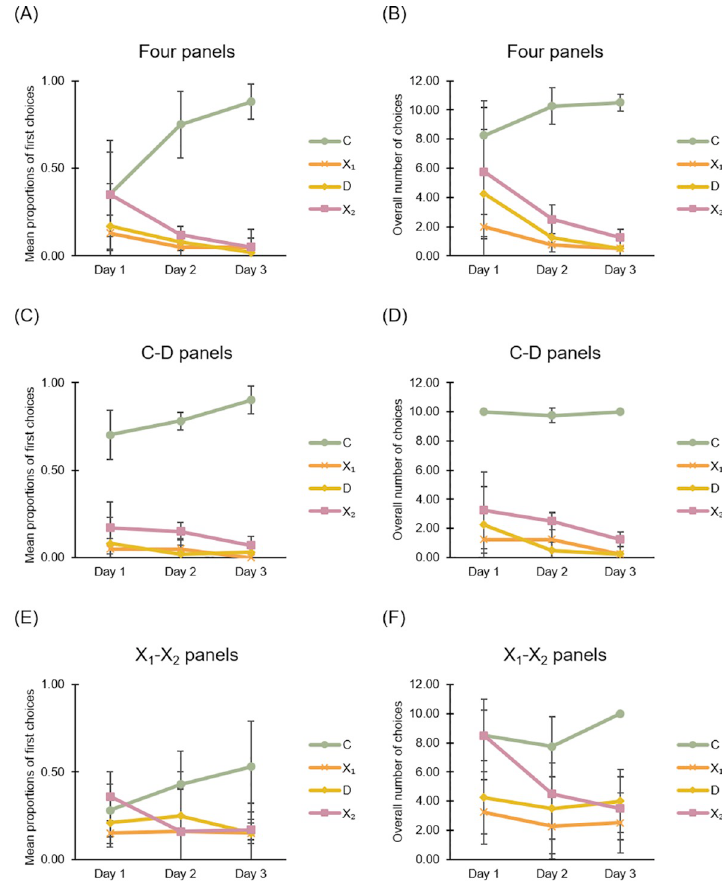
Fig 8. Learning in Experiment 3: Reference memory task in square apparatus with panels. (A) and (B): Graphs show mean (SD) choices at four corridors during the three daily sessions of training (reference memory for rewarded exit) in the square apparatus with four panels at corners, considering in (A) the proportions of first choices and in (B) the overall number of choices. (C) and (D): Graphs show mean (SD) choices during the three daily sessions of training in the square apparatus with two panels at corners C-D, near to the correct corner C, considering in (C) the proportions of first choices and in (D) the overall number of choices. (E) and (F): Graphs show mean (SD) choices during the three daily sessions of training in the square apparatus with two panels at corners X1-X2, far from the correct corner C, considering the proportions of first choices (E) and the overall number of choices (F).